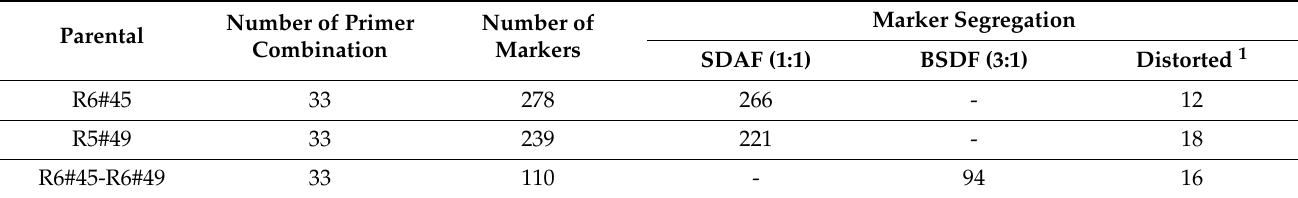
Table 5. Details of AFLP markers segregation in mapping